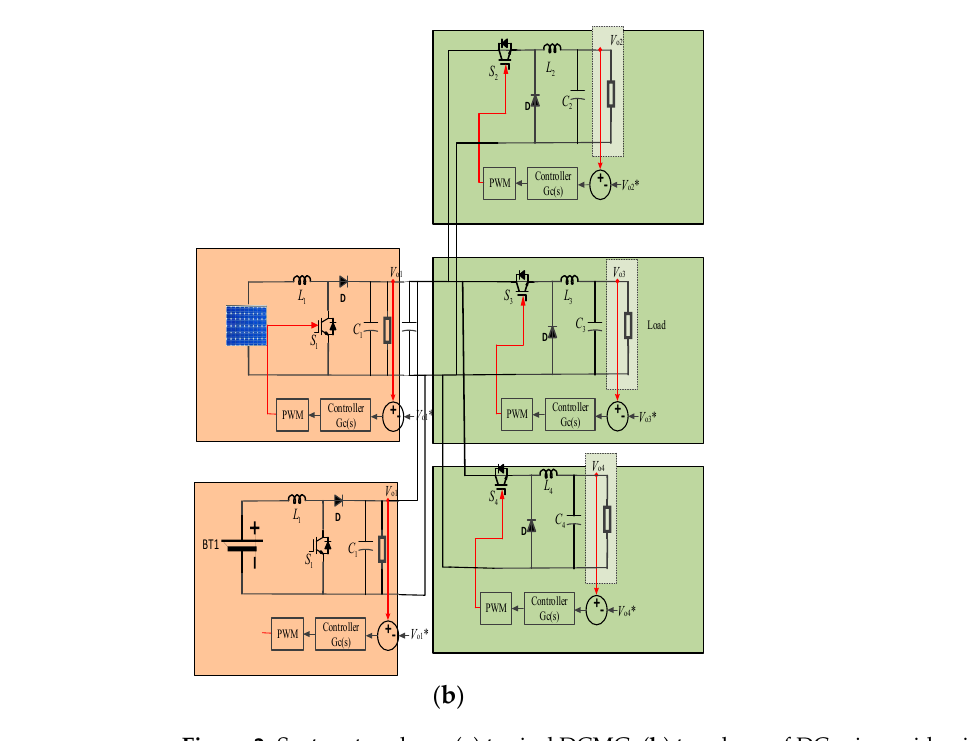
Figure 2. System topology; ( a ) typical DCMG; ( b ) topology of DC microgrid using in this work. Table 2. Parameters of the DC microgrid used in this work.